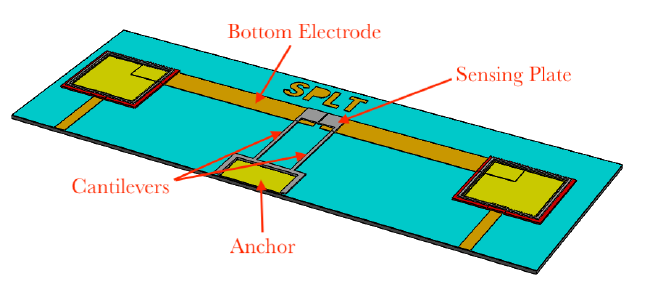
Figure 1. Layout of the gas